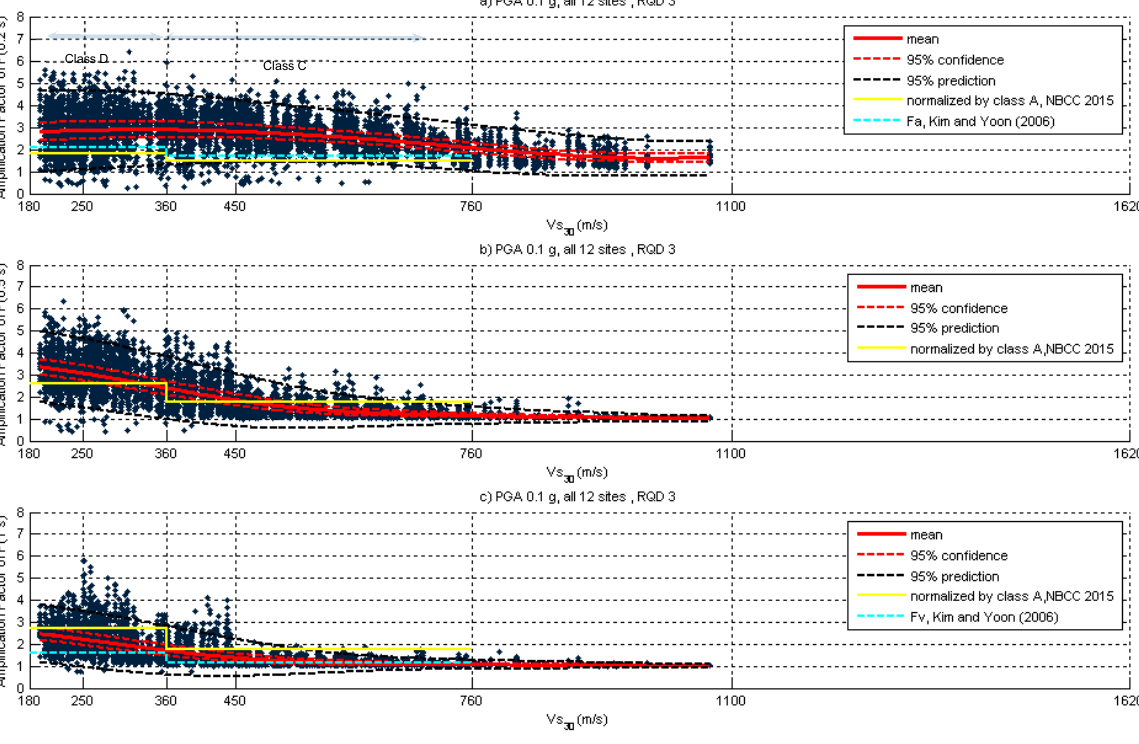
Figure 14. Amplification factors as a function of V s30 for periods of ( a ) 0.2 s, ( b ) 0.5 s, and ( c ) 1.0 s (RQD = 3, PGA = 0.1 g).